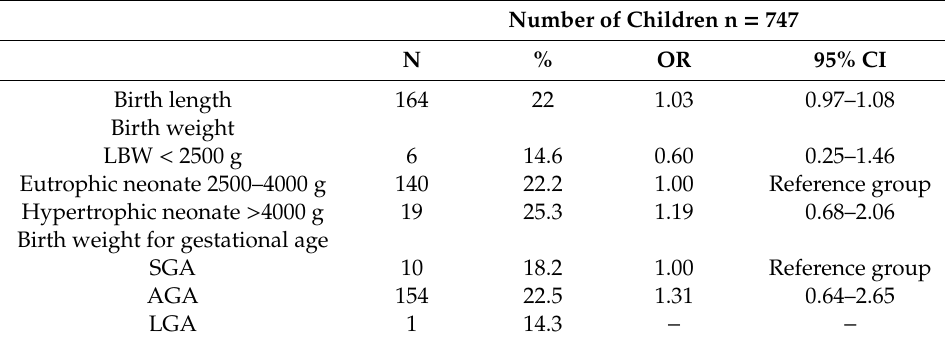
Table 6. Risk of hypertension in children, relative to birth length, birth weight as well as birth weight for gestational age.